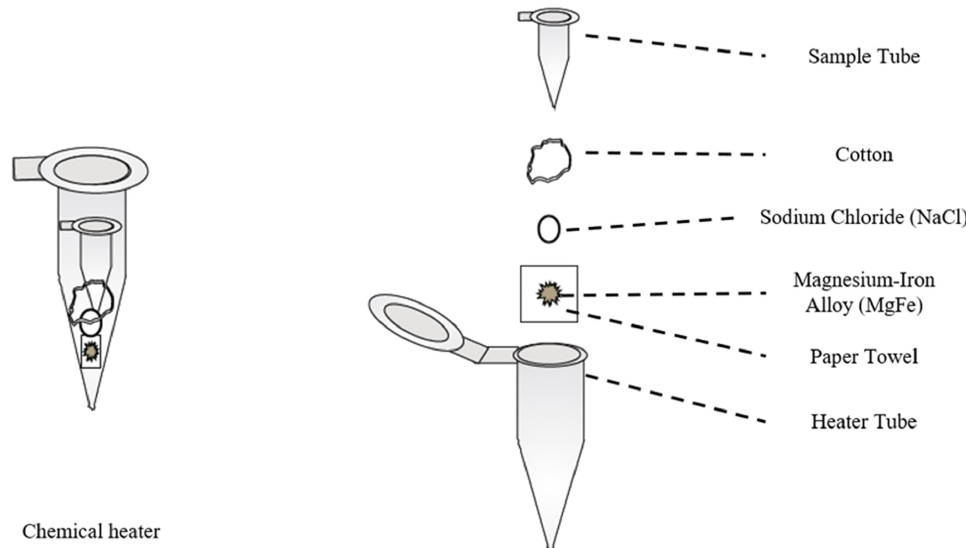
Figure 8. Portable chemical heater ( left ) for rapid lysis in point-of-care (POC) or low-resource settings (LRSs). Exploded view of the components and assembly ( right ). From Buser et al . , 2016 [112].